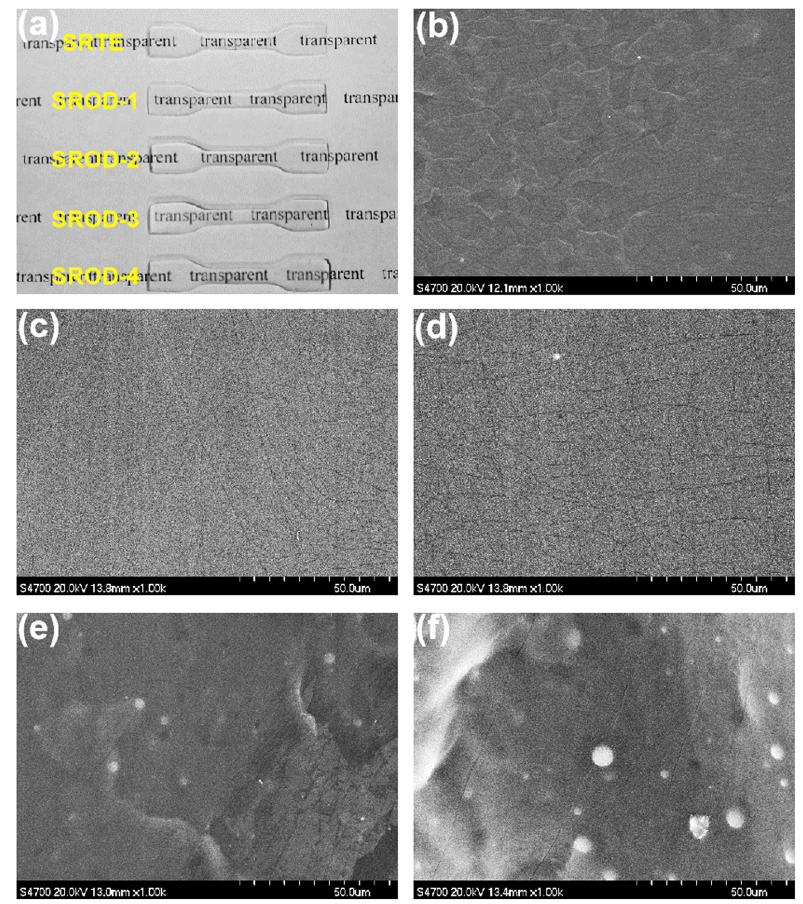
Figure 4: Visual images and morphologies of RTV silicone rubber: ( a ) visual images of SRTE and SROD; ( b ) SEM images of SRTE; ( c ) SEM images of SROD - 1; ( d ) SEM images of SROD - 2; ( e ) SEM images of SROD - 3; and ( f ) SEM images of SROD - 4.